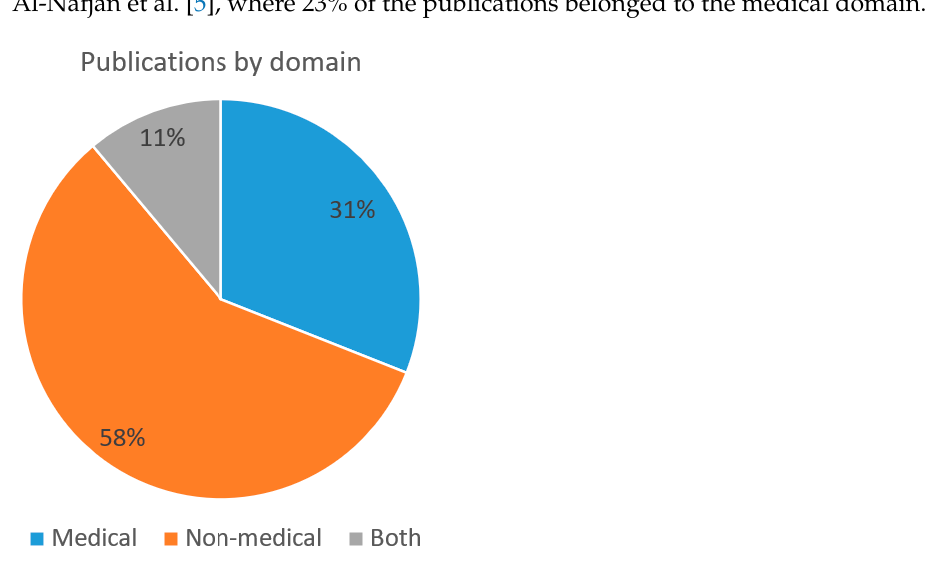
Figure 5. Distribution of publications per domain. The figure illustrates the distribution of the publications among medical and non-medical domain and volume of the publications covering both domains.